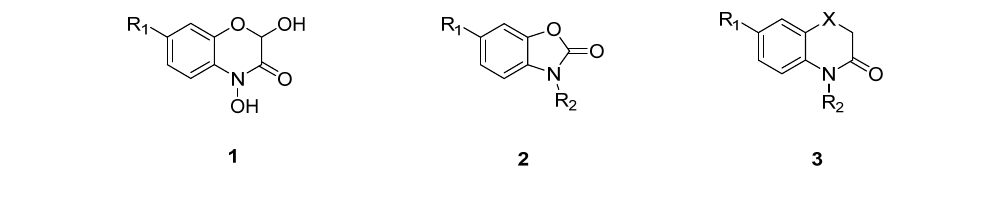
Figure 5. Analogues of dimboa (R 1 = -H) and its degradation product moba (R 1 = -OCH 3 , R 2 = -H).